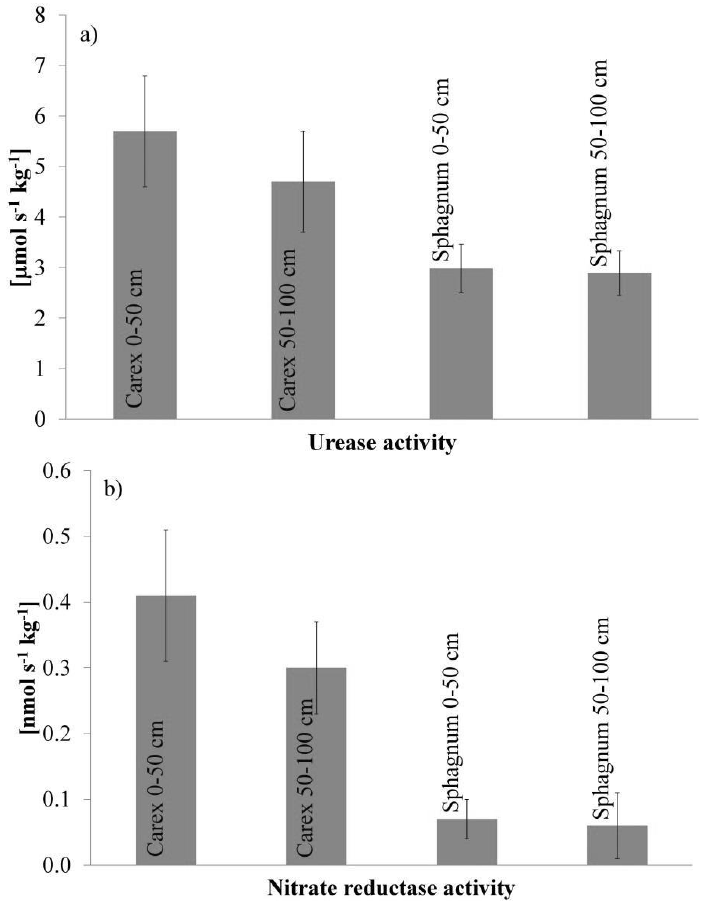
Figure 2. Enzymes participating in both hydrolytic and redox processes in studied soils: a) urease, b) nitrate